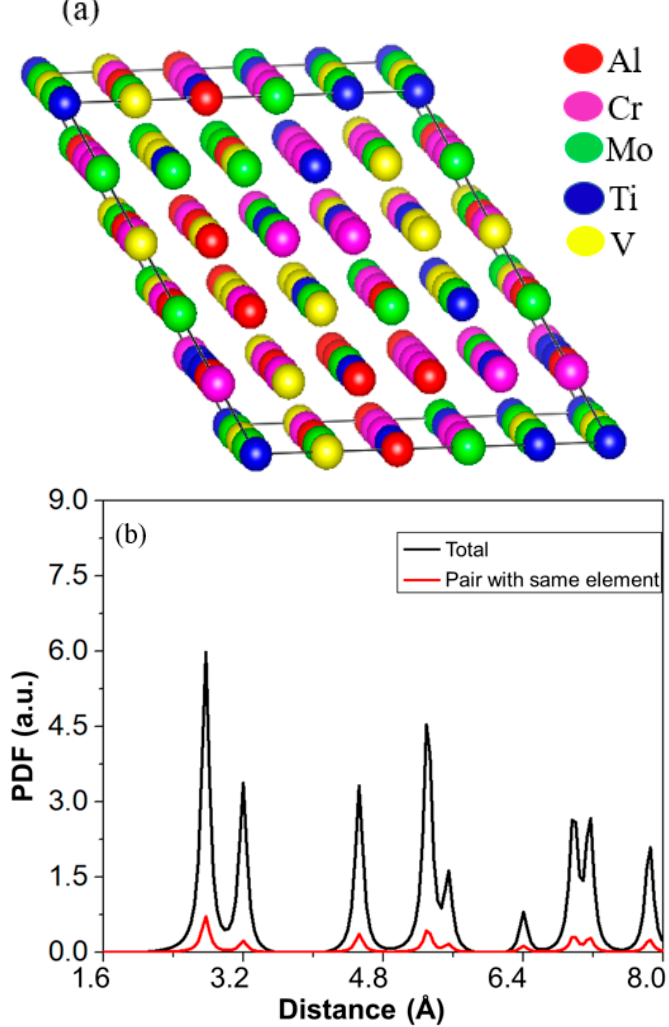
Figure 1. ( a ) Schematic of a random 100-atom unit cell model used for densitiy functional theory (DFT) calculations. ( b ) Plot between total pair distribution function (PDF) of all pairs in the supercell and total PDF of pairs as a function of distance.